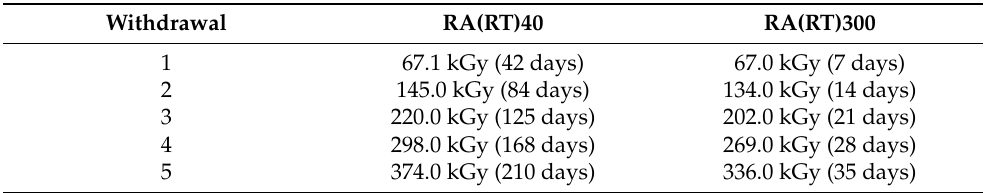
Table 1. Integrated gamma doses (and ageing time) for the five withdrawals at each dose rate (RA(RT) 40: radiolytic ageing of 40 Gy/h at room temperature, RA(RT)300: radiolytic ageing of 300 Gy/h at room